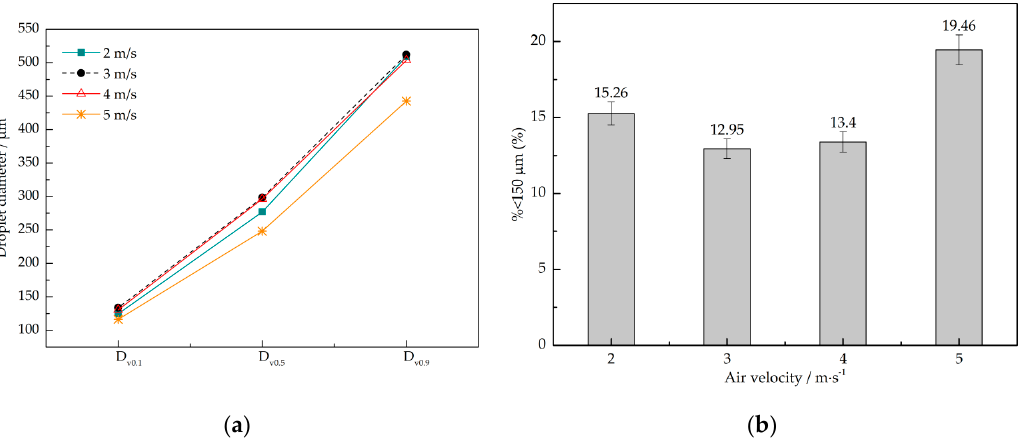
Figure 3. ( a ) Volume diameters below which smaller droplets constitute 10%, 50% and 90% of the total spray volume (D v0.1 , D v0.5 and D v0.9 ), and ( b ) proportion of spray volume contained in droplets with a diameter below 150 µm (% < 150 µm) for 11001 under different air velocities (2~5 m/s) at 400 kPa.